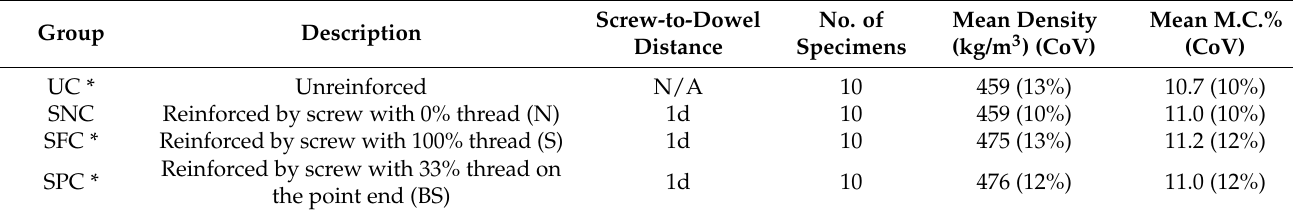
Table 2. Summary of groups in the connection tensile test.